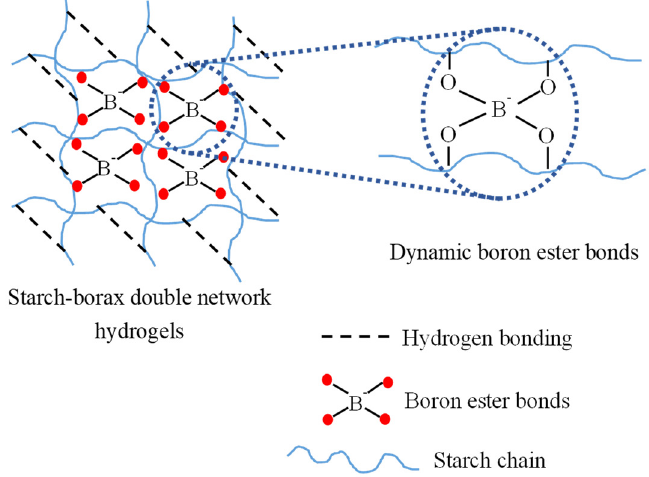
Figure 8. ( A ) Self-healing process diagram of starch–borax 3.5% DC hydrogels. ( B ) Visual evidence of self-healing of starch–borax DC hydrogels.